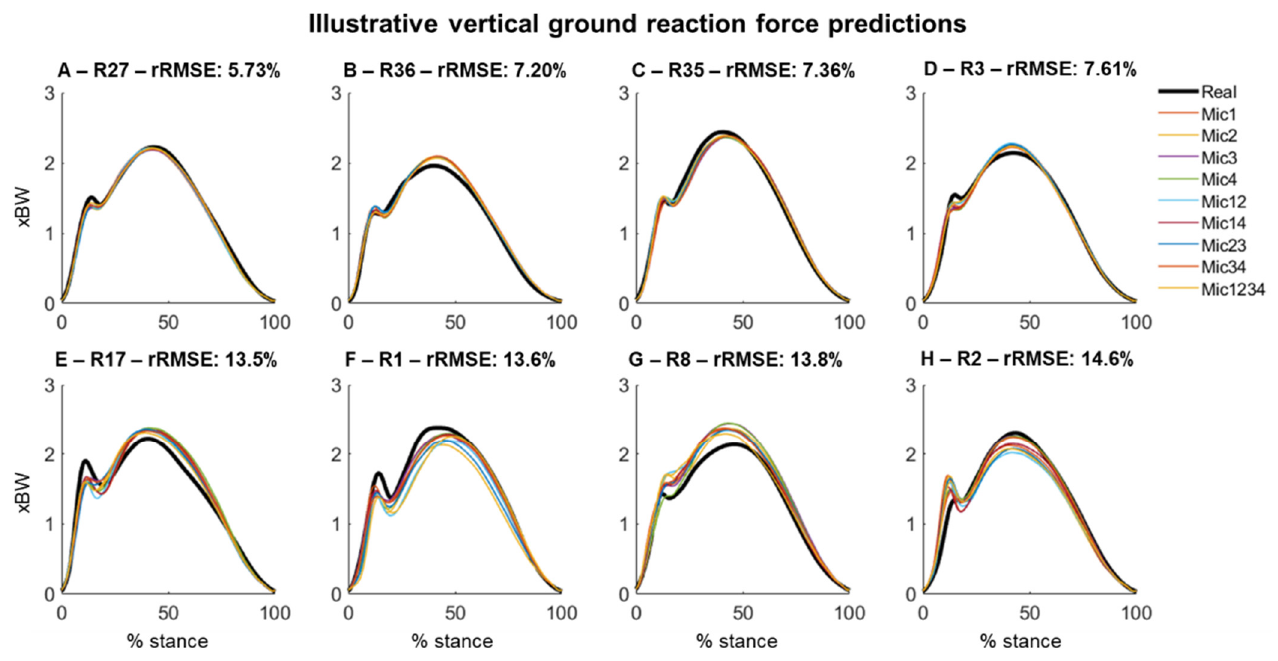
Figure 4. Vertical ground reaction force prediction (normalized to body weight [xBW]) using sounds recorded from different combinations of microphones. Each curve is an average across all cycles from the same runner. The top row ( A – D ) shows the data for selected runners (R) with the lowest average relative root ‐ mean ‐ square prediction error (rRMSE), whereas the bottom row ( E – H ) shows the data for runners with the highest prediction error.